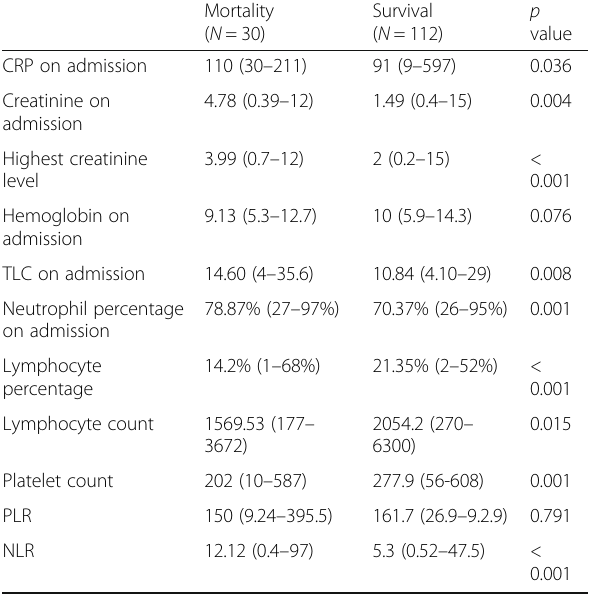
Table 4 Laboratory predictors of in-hospital mortality